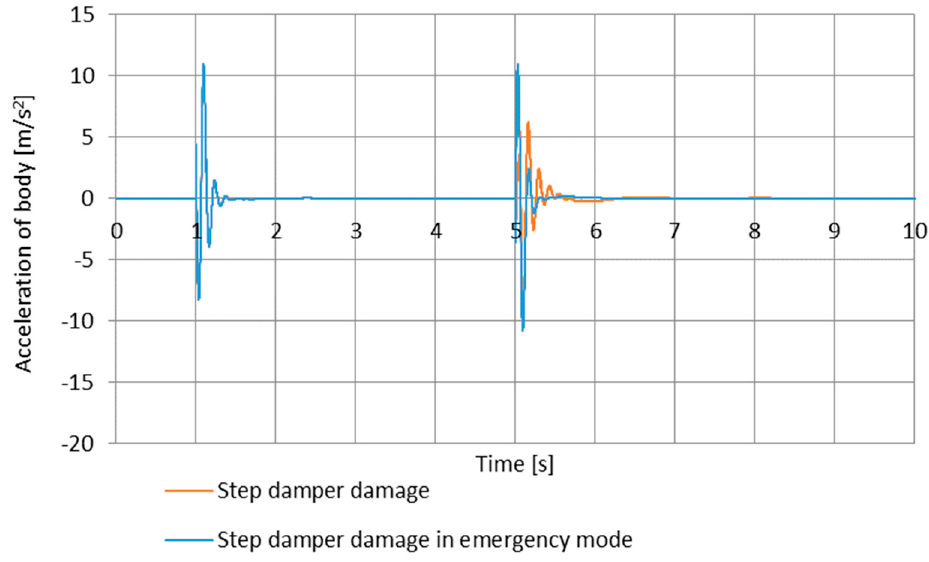
Figure 9. Body vertical acceleration for a step-damaged damper with introduction of an emergency mode.